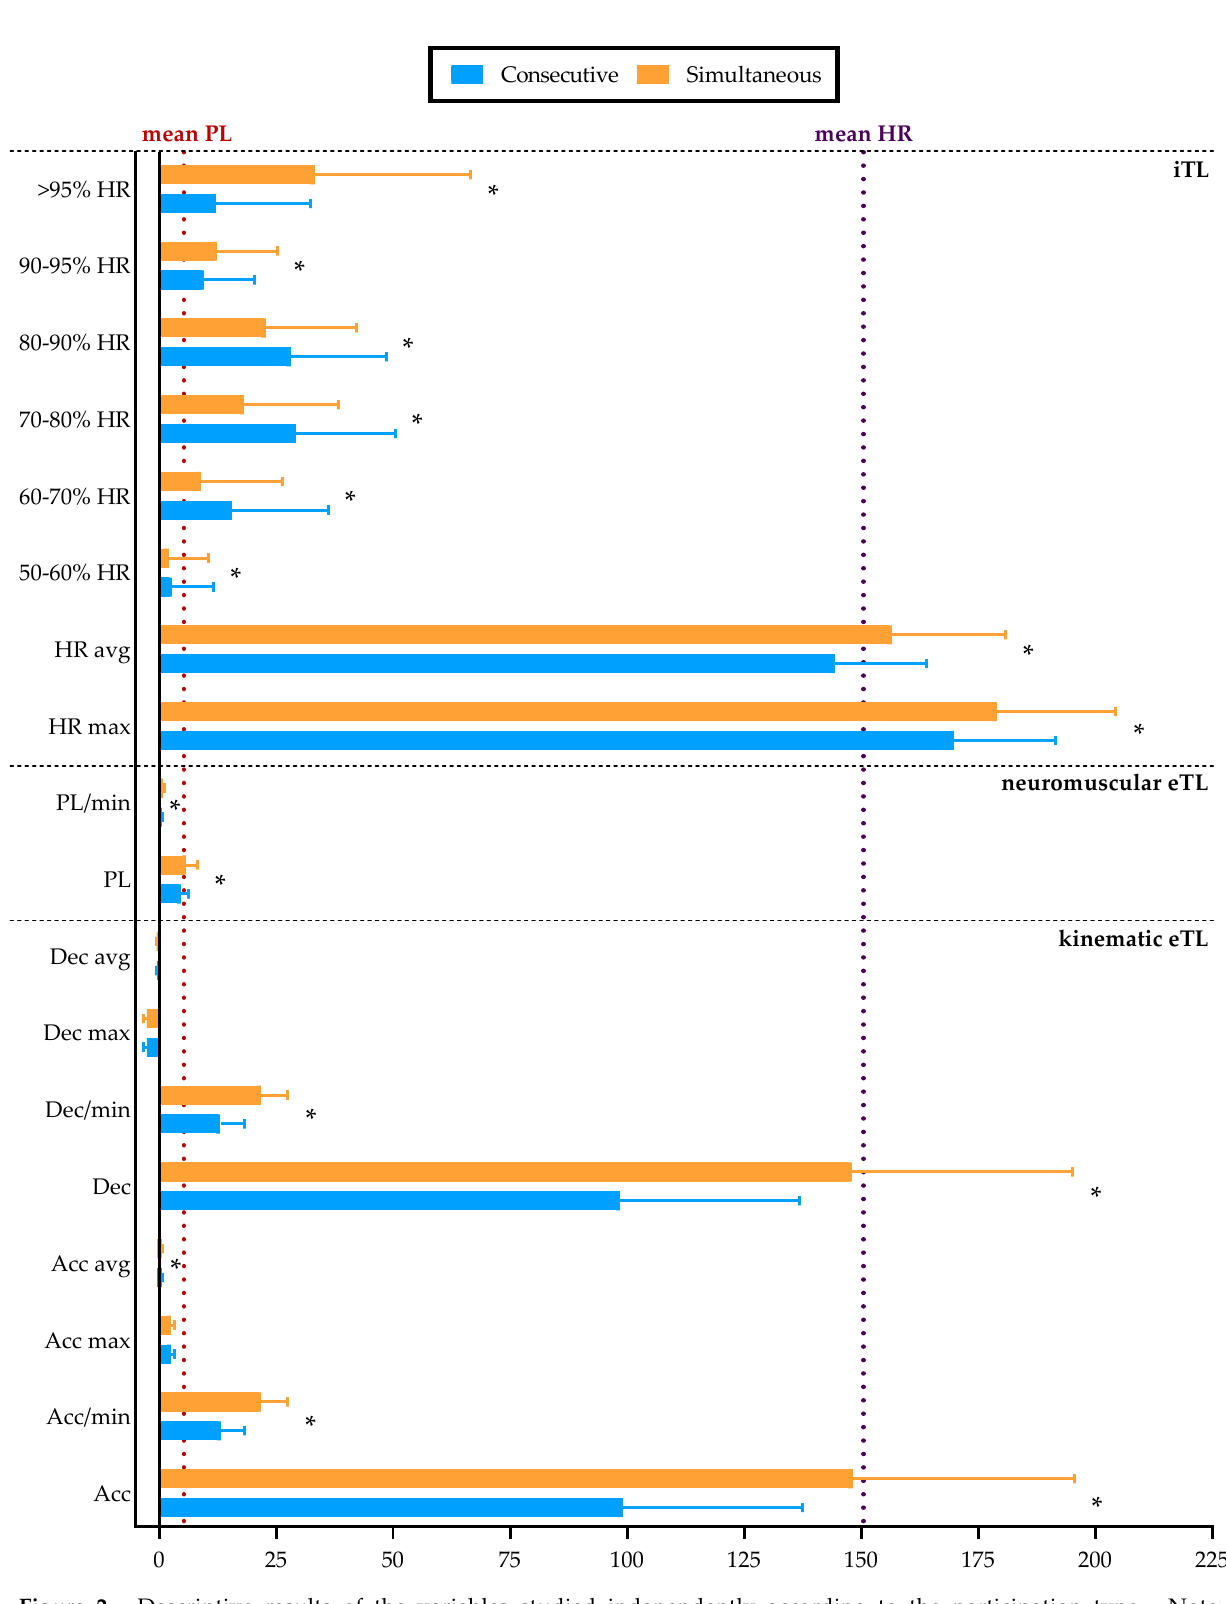
Figure 2. Descriptive results of the variables studied independently according to the participation type. Note: eTL = external load; Acc = acceleration; Dec = deceleration; PL = Player Load; iTL = internal Load; HR = Heart Rate; min = minute; max = maximum; avg = average. * p < 0.05.